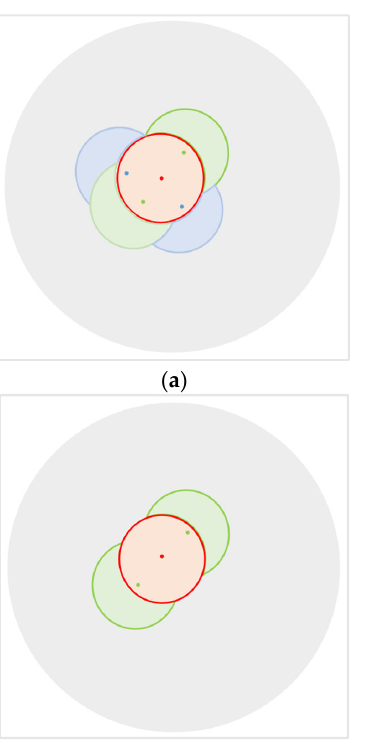
Figure 14. The value change trend of three indices (recall, precision, and F-score) and computation time with the variation of the parameter seed number.